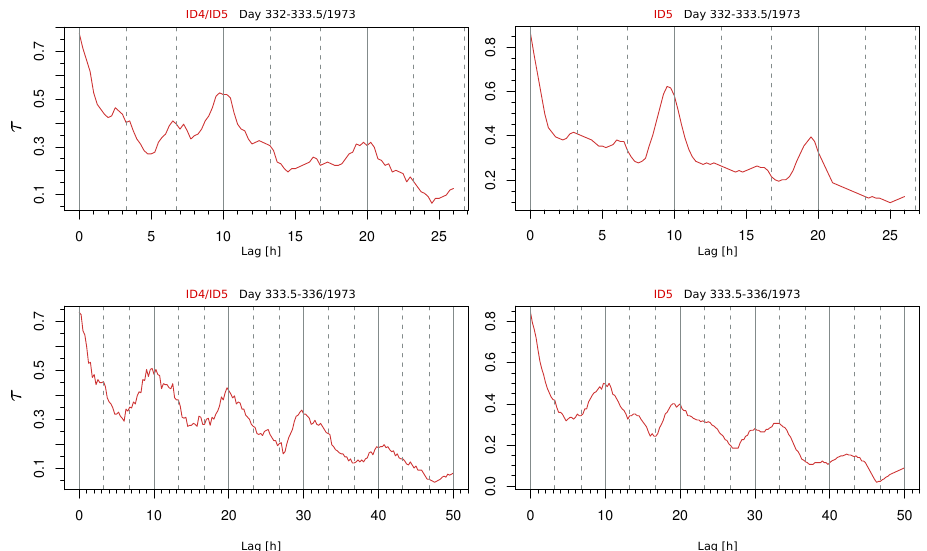
Fig. 8. Ranked autocorrelation analysis of Pioneer 10 data for days 332 to 333.5 (top) and 335.5-336 (bottom). The left panels show the id4/id5 ratio data and the right the id5 counting rate data. The 10 h periodicity of the major peaks is present for all data sets. However, similar to the Ulysses data, a second modulation can be identified in the id4/id5 and id5 data for days 332-332.5. This modulation is weaker pronounced due to the short time period used for this analysis and the fact that the minor peaks are not as well established as for Ulysses. During the time interval from day 333.5 to 336, there is no satisfying evidence for minor peaks.